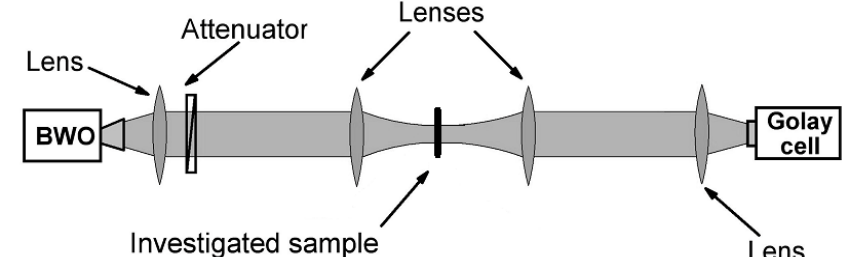
Fig. 1. Experimental setup of spectrometer for research electrophysical properties of composite materials in EHF